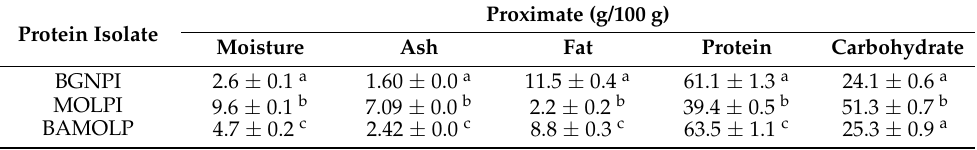
Table 2. Chemical composition of BGNPI, MOLPI, and BGNMPC (g/100 g) 1,2 . Proximate (g/100 g) Protein Isolate Moisture Ash Fat